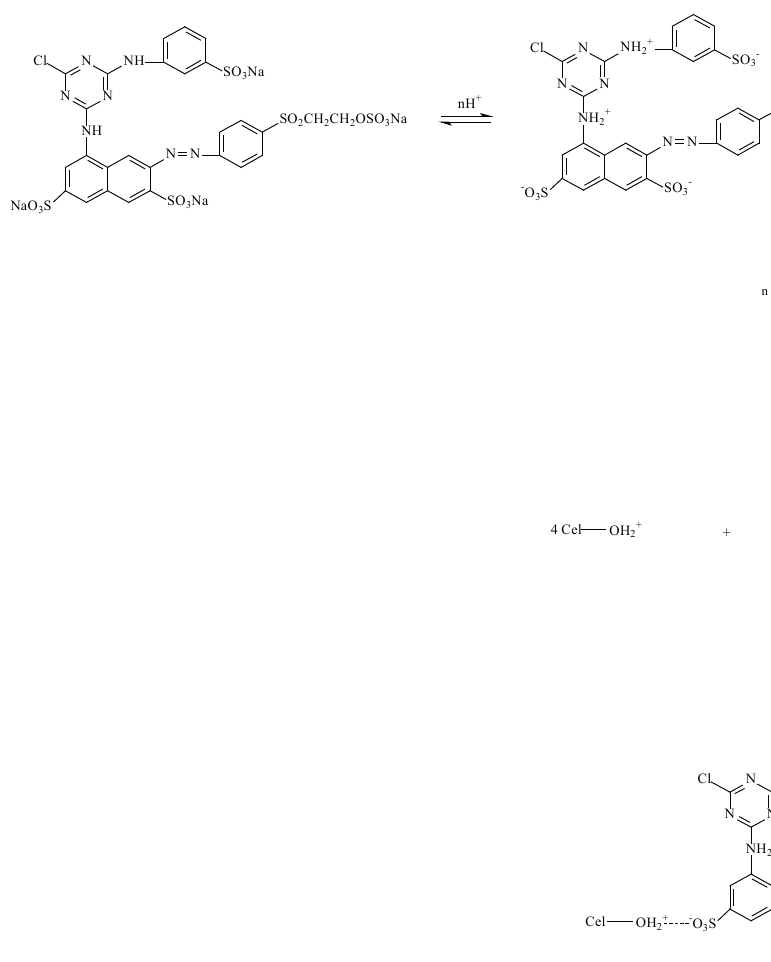
Figure 9: Diagram of the adsorption process of the cellulose matrix and the reactive red RB dye in an acidic